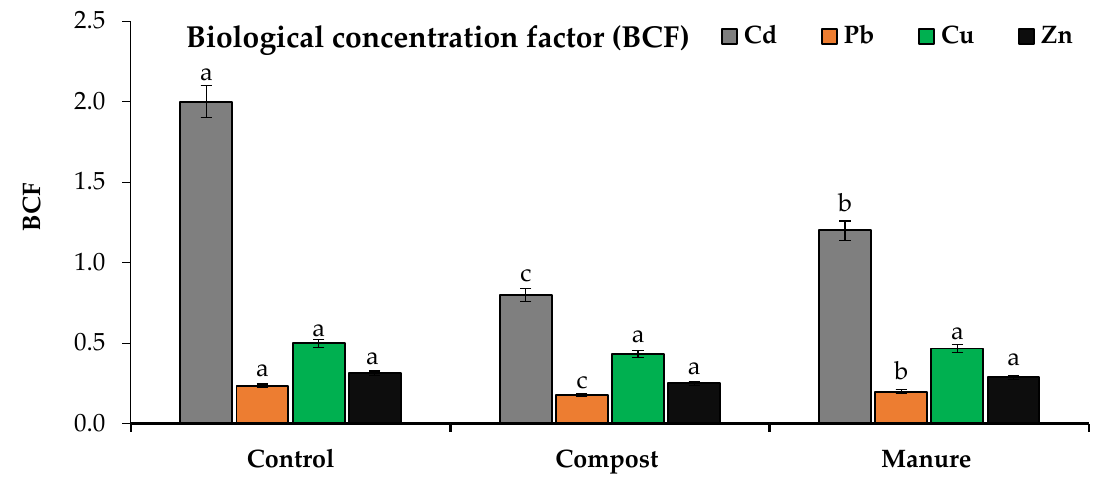
Figure 4. Effect of compost and manure on the biological concentration factor (BCF). Means (±standard deviation, n = 4) denoted by different letters are significantly different at p < 0.05.